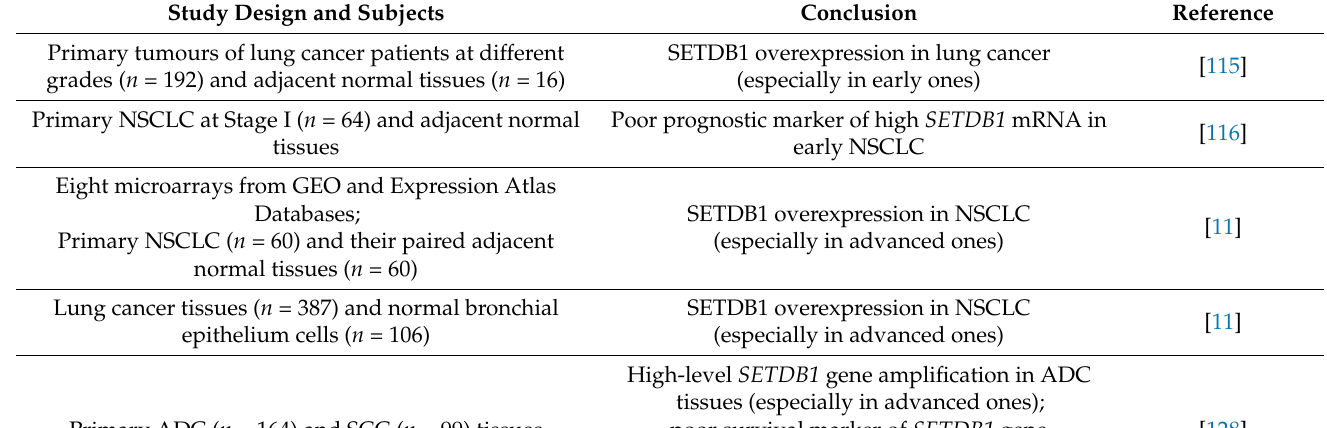
Table 3. SETDB1 status in primary lung cancer and